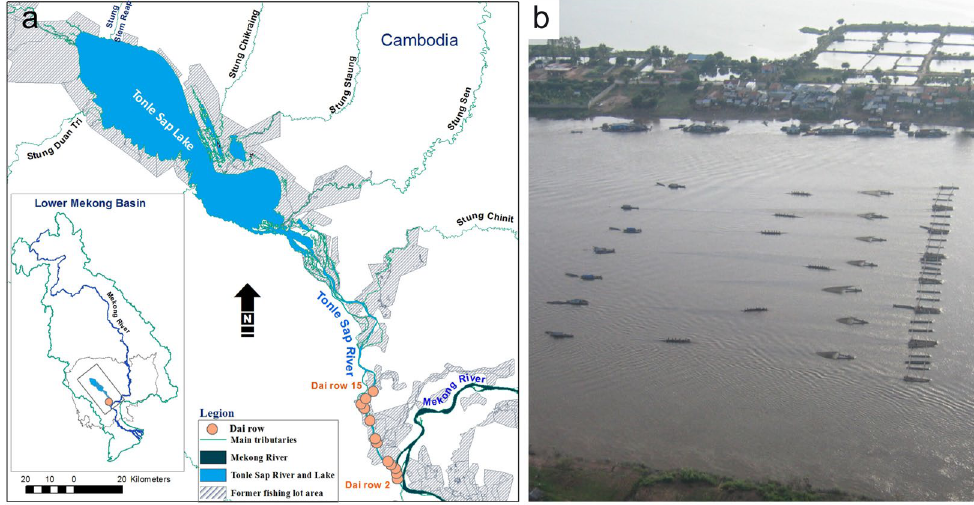
Figure 6. Dai fishery in the Tonle Sap River: ( a ) location of Dais ; ( b ) an aerial photo of a Dai row with seven units in operation. Map is created using ArcMap